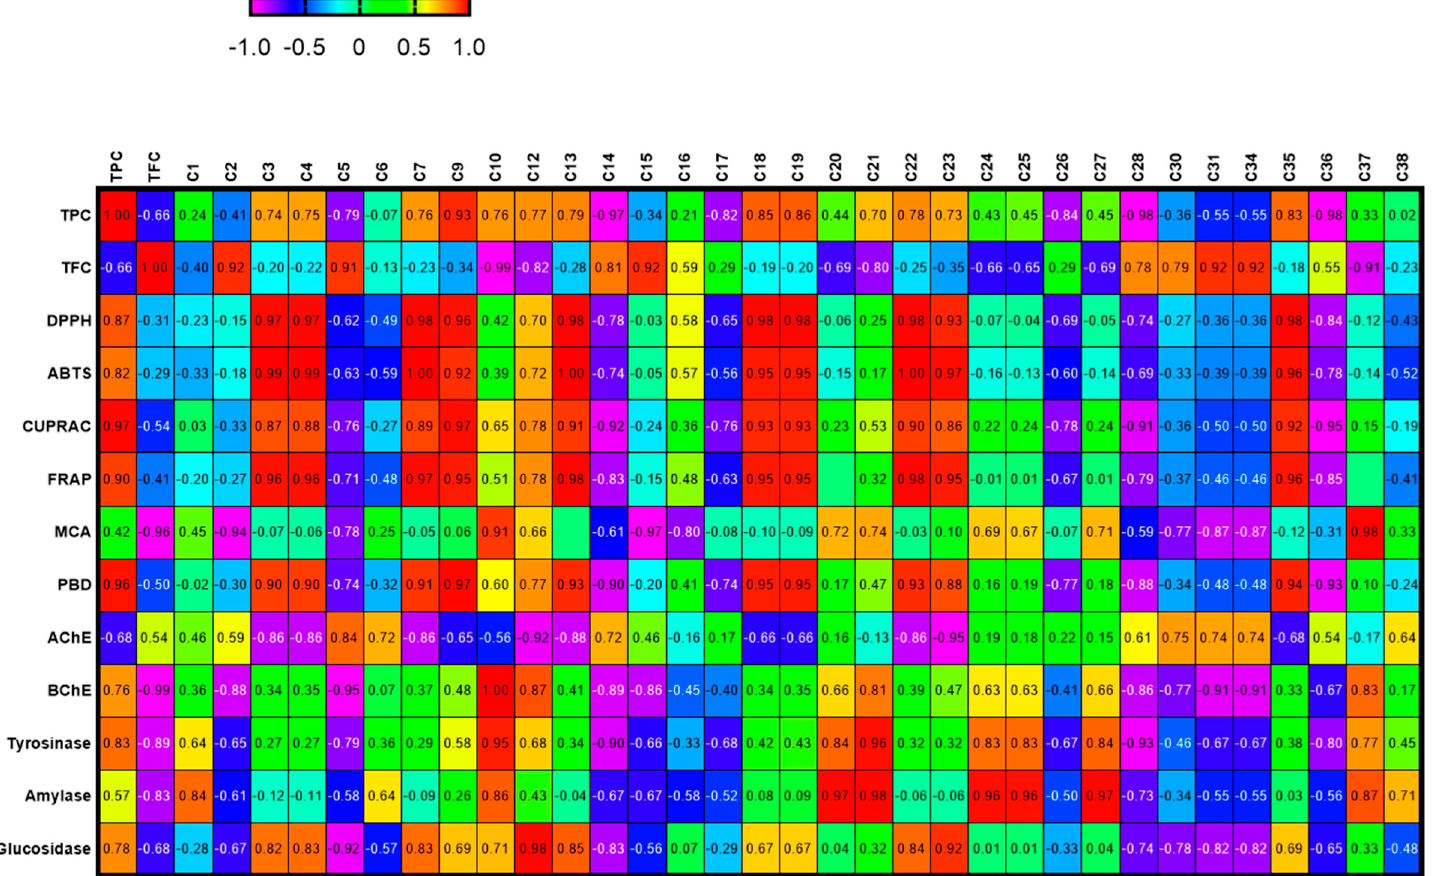
Figure 1. Relationship between secondary metabolites and biological activities of the tested extracts. For compound numbers refer to Table 1. The correlation is considered positive and statistically significant (r > 0.7).